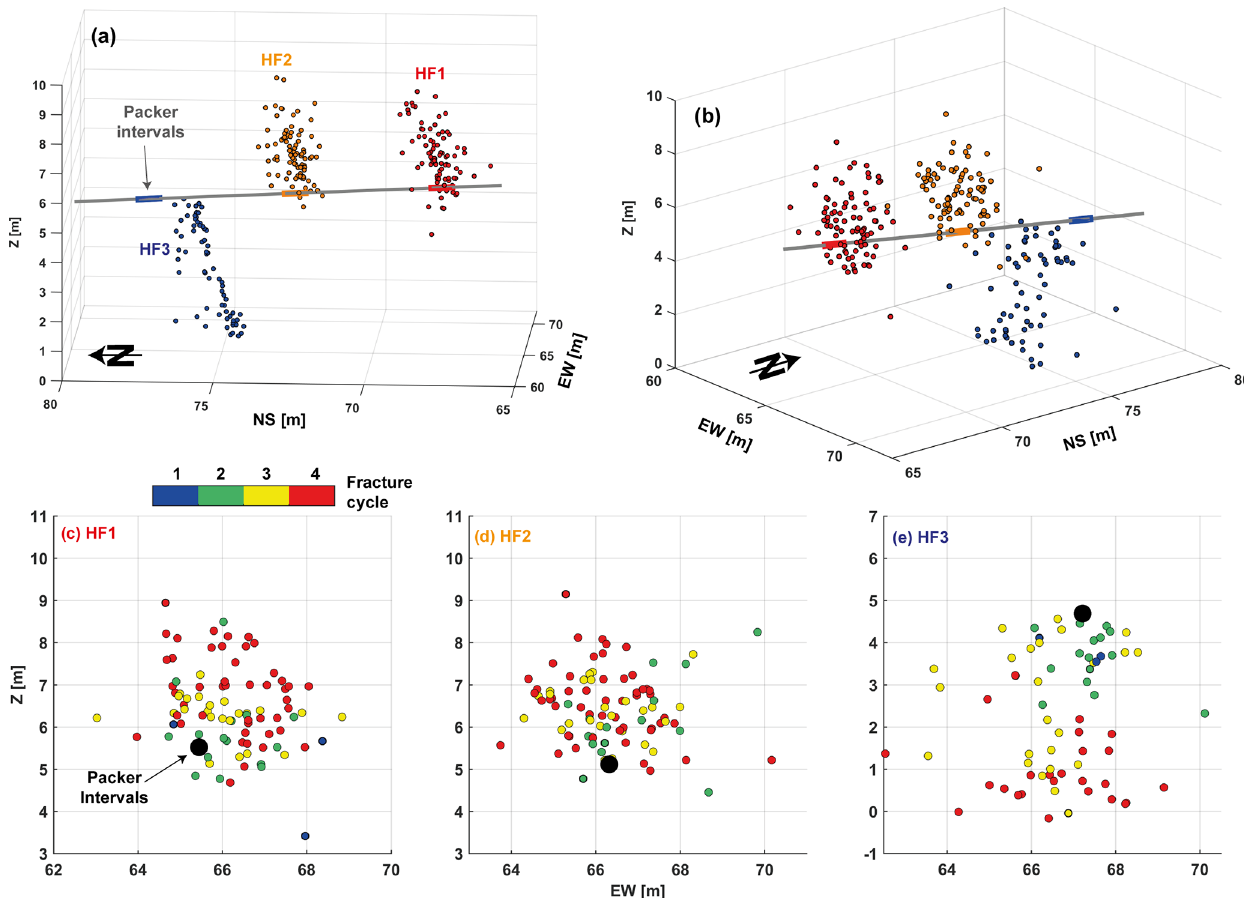
Figure 5. ( a and b ) Seismicity clouds of HF1-3 using absolute locations derived from JHD. (c–e) Seismicity clouds (view towards north) with events coloured according to the injection cycle during which it occurred (data available in Gischig et al.,